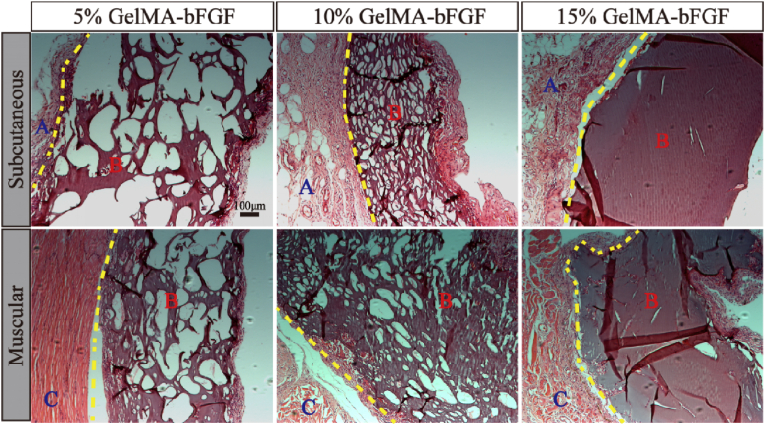
The HE images of GelMA-bFGF hydrogels implanted in subcutaneous and ischial gastrocnemius for 30 days. Yellow line: the boundary line of tissue and hydrogel; A: fibrous tissue; B: hydrogel; C: muscle. (For interpretation of the references to colour in this figure legend, the reader is referred to the Web version of this article.)